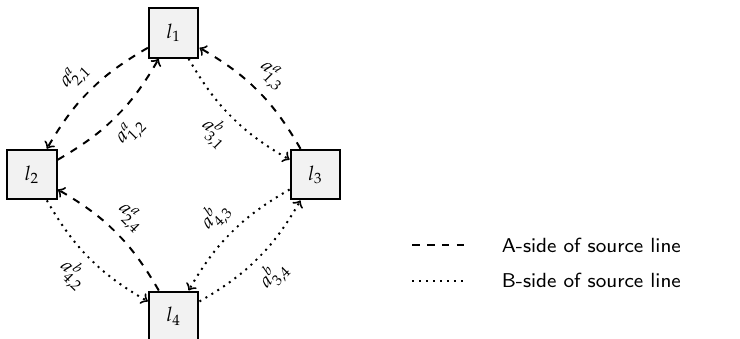
Figure 3. Transformed 4-bus system. Transmission lines as vertices, edges as propagation paths. Labeled edges correspond to elements in the resulting adjacency matrices marked with a digit